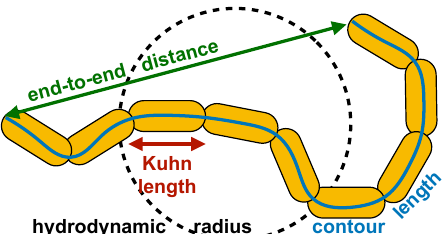
Figure 6. Scheme of polymer structural parameters. The cartoon sketches the main structural parameters identified in the experimental work, namely the end-to-end distance (green solid arrow), the contour length (blue solid curve), the hydrodynamic radius (black dashed circle), and the Kuhn length (red solid arrow).